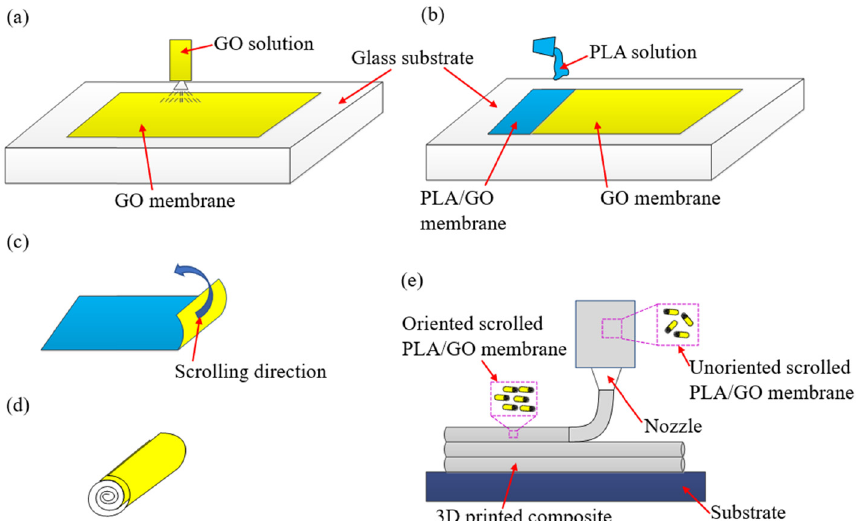
Figure 7: Schematic diagram of making highly oriented 2D nanomaterials for 3D printed composites. ( a ) Graphene oxide ( GO ) solution is sprayed on the surface of the glass substrate to form a GO membrane. ( b ) Polylactic acid ( PLA ) solution is cast on the surface of GO solution to form PLA/GO membrane. ( c ) PLA/GO membrane is scrolled. ( d ) Unoriented scrolled PLA/GO membrane is transferred to oriented scrolled